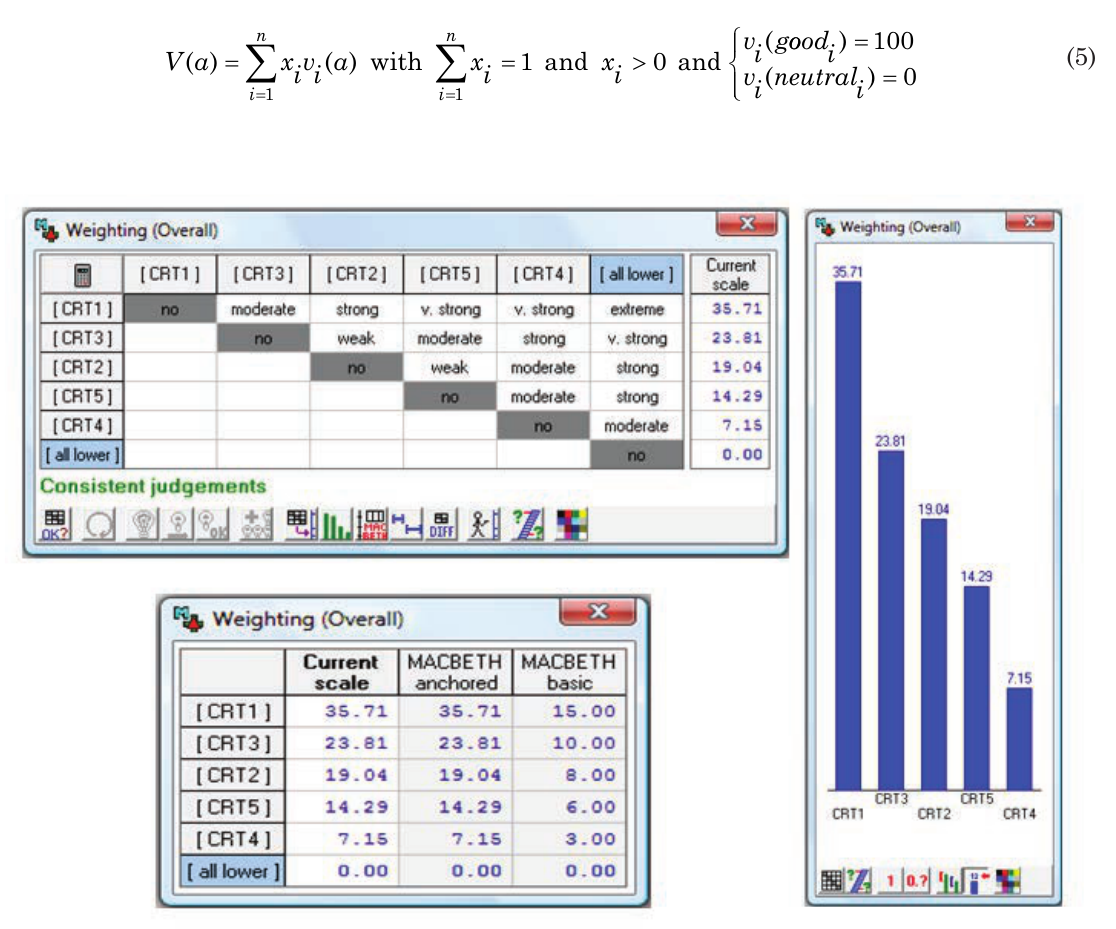
Figure 4. criteria